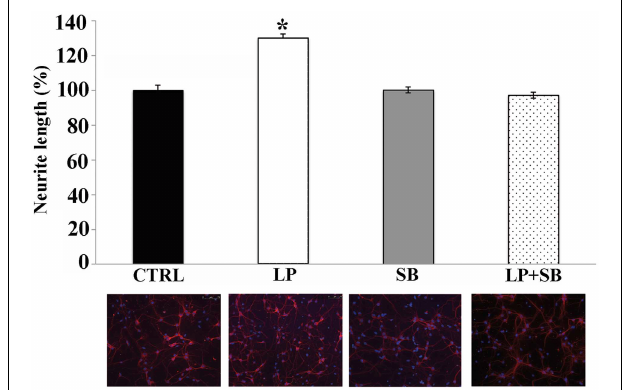
FIGURE 7 | Stimulation of 5-HT7R enhances neurite outgrowth in hippocampal primary cultures. Hippocampal cells were treated for 2h with the 5-HT7R selective agonist LP-211 (LP, 100nM), alone or in combination with the selective 5-HT7R antagonist SB269970 (SB, 100nM). Neurite length was measured on cells stained with anti-Tuj1 antibody, and expressed as percentage of values measured in the corresponding vehicle-treated cultures (CTRL, set to 100%). The bars represent means ± SEM from randomly selected fields for each cell culture conditions ( n = 10 ). Asterisk (*): values significantly different from CTRL by One Way ANOVA followed by Dunnett post-hoc test ( p < 0 . 05 ). The panels below each bar display representative images of hippocampal neurons immunostained with the neuronal marker Tuj1 (red) and counterstained with the nuclear marker DAPI (blue; magnification